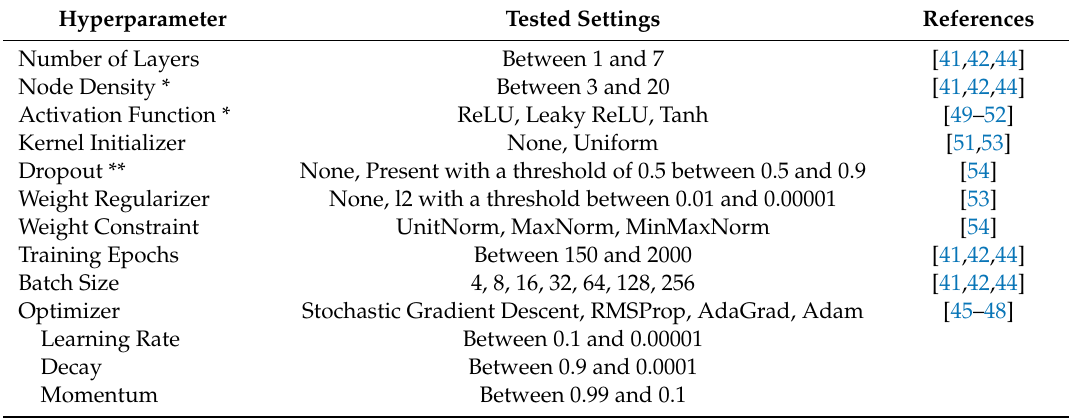
Table 1. List of hyperparameters and settings tested during optimization of final Feed Forward Neural Networks (FFNN) model architecture and